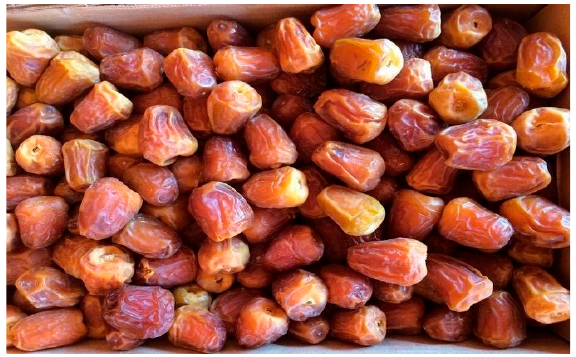
Figure 22. Sample of Al-skari dates.